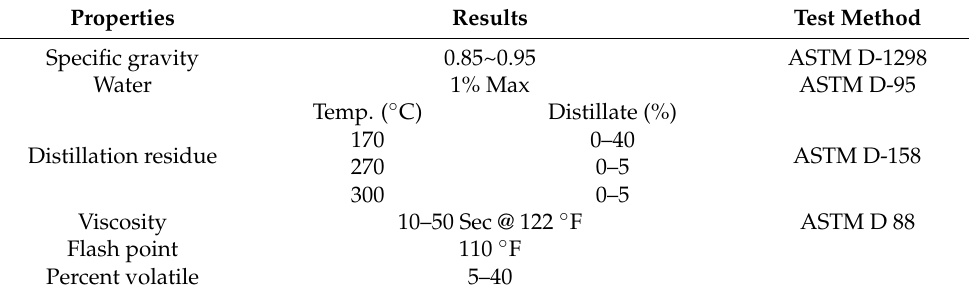
Table 2. Physical properties of the asphalt rejuvenator.